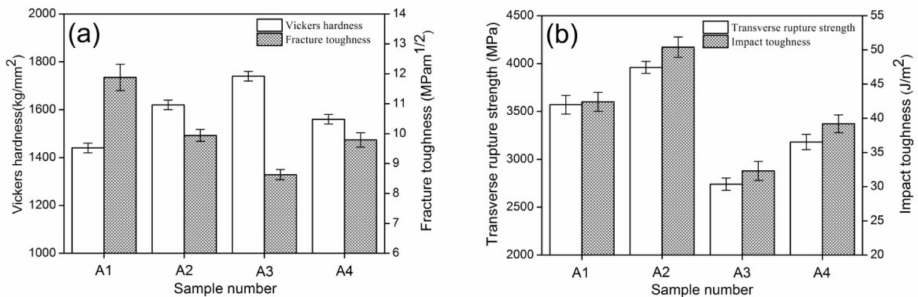
Figure 13. Mechanical properties of WC–10 wt. % Co sintered samples. ( a ) Vickers hardness and fracture toughness; ( b ) transverse rupture strength and impact toughness. A1: WC–10Co; A2: WC–10Co–0.8Cr 3 C 2 ; A3: WC–10Co–0.8VC; A4: